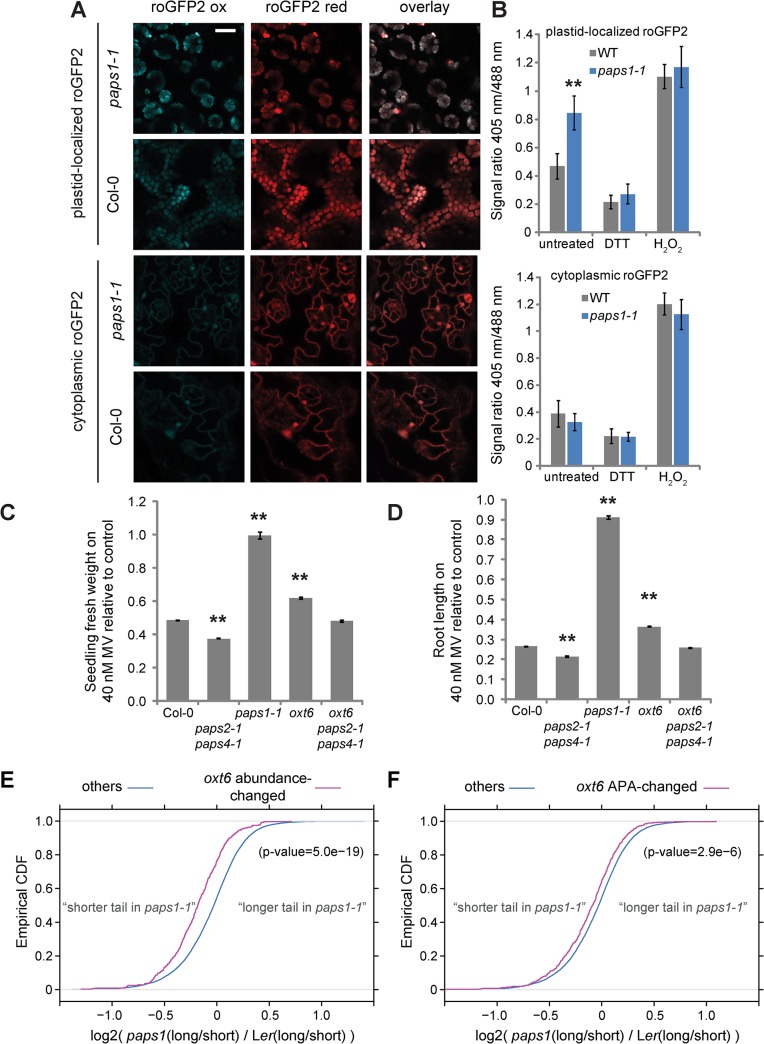
Role of PAPS1 in redox homoeostasis and oxidative-stress response.(A) False-colored images showing roGFP2 fluorescence in the two genotypes and subcellular localizations indicated after excitation with 405 nm (roGFP2 ox) and 488 nm (roGFP2 red), and overlay of the two images. While cytoplasmic roGFP2 was imaged in the epidermis, plastid-localized roGFP2 was imaged in mesophyll cells, as in the epidermis it was only visible in stomatal guard cells. Scale bar is 20 μm. (B) Quantification of the ratio of roGFP2 fluorescence emission after excitation with 405 nm and 488 nm. DTT, H2O2: controls after treating plants with DTT to reduce and H2O2 to oxidize roGFP2 protein. Values are mean ± SEM of three biological replicates. (C) Fresh-weight analysis of seedlings of the indicated genotypes treated with 40 mM methyl-viologen relative to untreated controls. Values are mean ± SEM of at least 20 seedlings per genotype. (D) Root length of seedlings of the indicated genotypes treated with 40 mM methyl-viologen relative to untreated controls. Values are mean ± SEM of at least 20 seedlings per genotype. **: significantly different from control at p<0.01 based on Student’s t-test with Bonferroni correction. Absolute values for fresh weight and root length are shown in S7 Fig (E,F) Empirical cumulative distribution functions (CDF) of tail-length change in paps1-1 mutants for transcripts with altered abundance (E) or altered alternative-polyadenylation (APA) patterns in oxt6 mutants (F) versus genomic background (others). Indicated p-values are from a Wilcoxon rank-sum test.